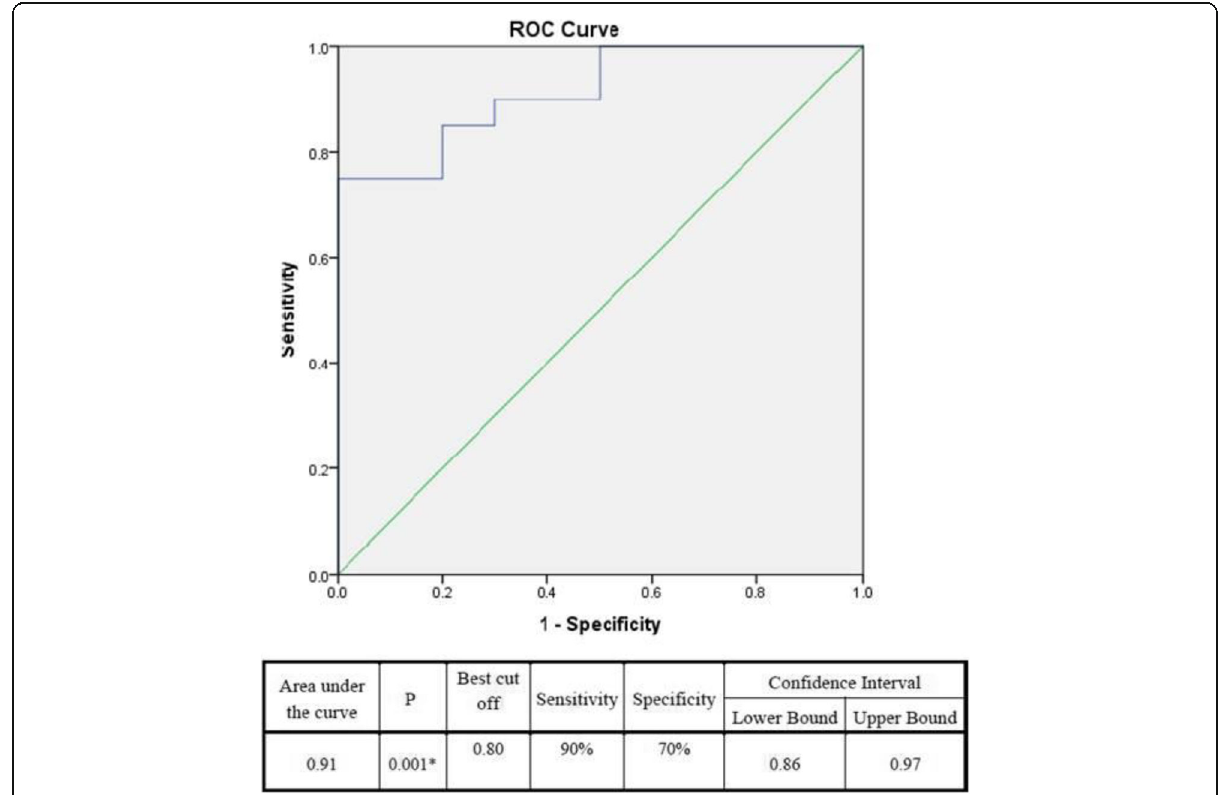
Fig. 4 ROC curve of the Apo B/Apo A ratio in patients with high Gensini